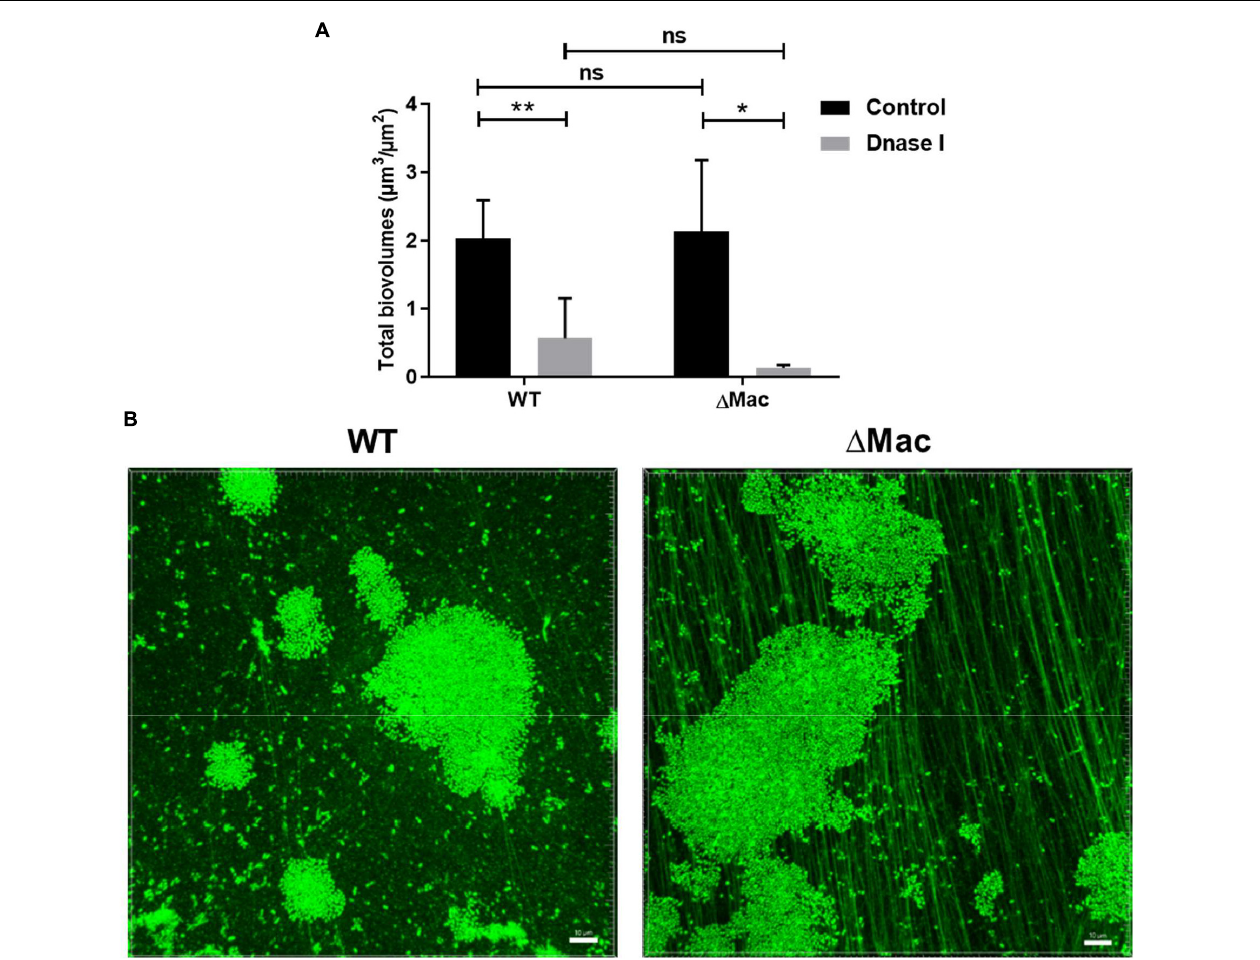
FIGURE 3 | Impact of macAB-tolC deletion on biofilm formation at the solid-liquid-air interface. (A) Total biovolume ( µ m 3 / µ m 2 ) of 24-h-old A. baumannii ATCC 17978 WT and (cid:49) Mac biofilms after exposure to DNase I (100 µ g/ml) compared to untreated control biofilms. Quantification of biovolume was based on the confocal fluorescence images of Syto9 stained biofilms. Data shown represent mean values ( ± SD) from at least three independent biological experiments (ns, not significant; * p < 0.05; ** p < 0.01). (B) Representative confocal fluorescence images of A. baumannii ATCC 17978 WT (left) and (cid:49) Mac biofilms (right) labeled with Syto9 at the solid–liquid–air interface (three-phase interface). Image construction was carried out using Imaris software. Scale bar: 10 µ